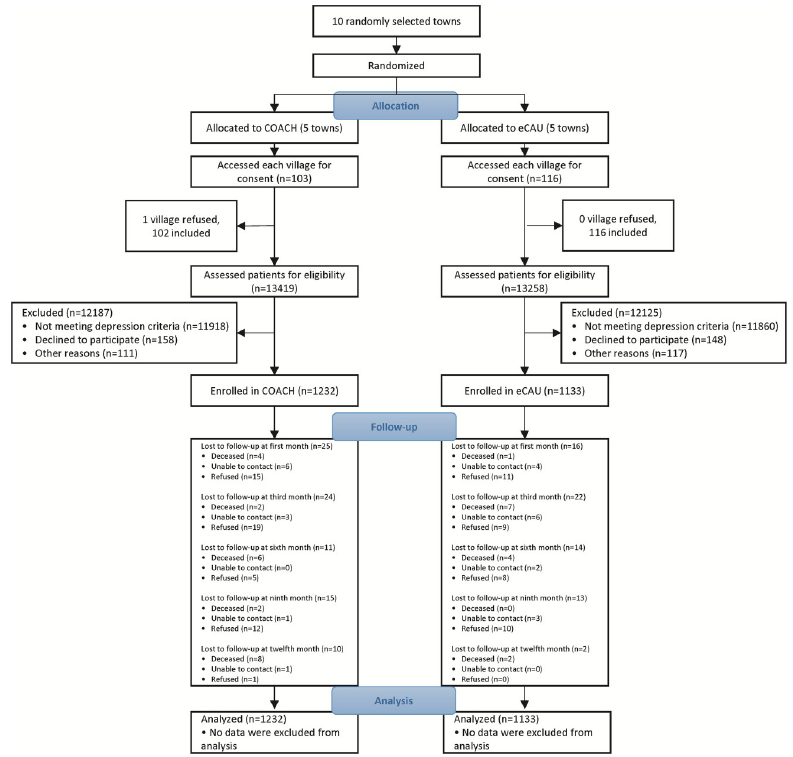
Fig 1. CONSORT diagram of COACH Study participant